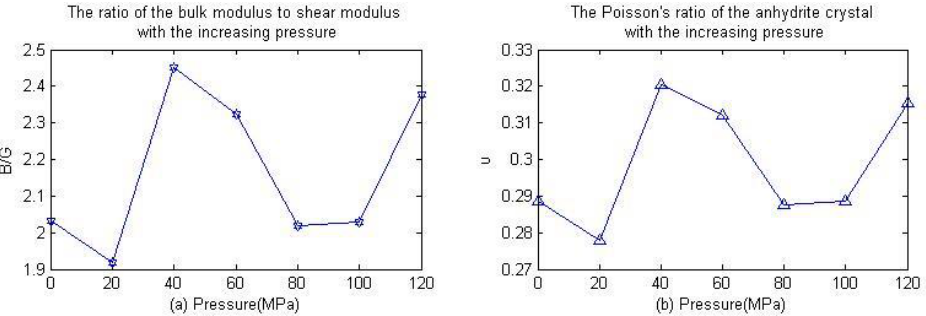
Figure 5. Ratio of bulk modulus to shear modulus and Poisson's ratio as a function of pressure.